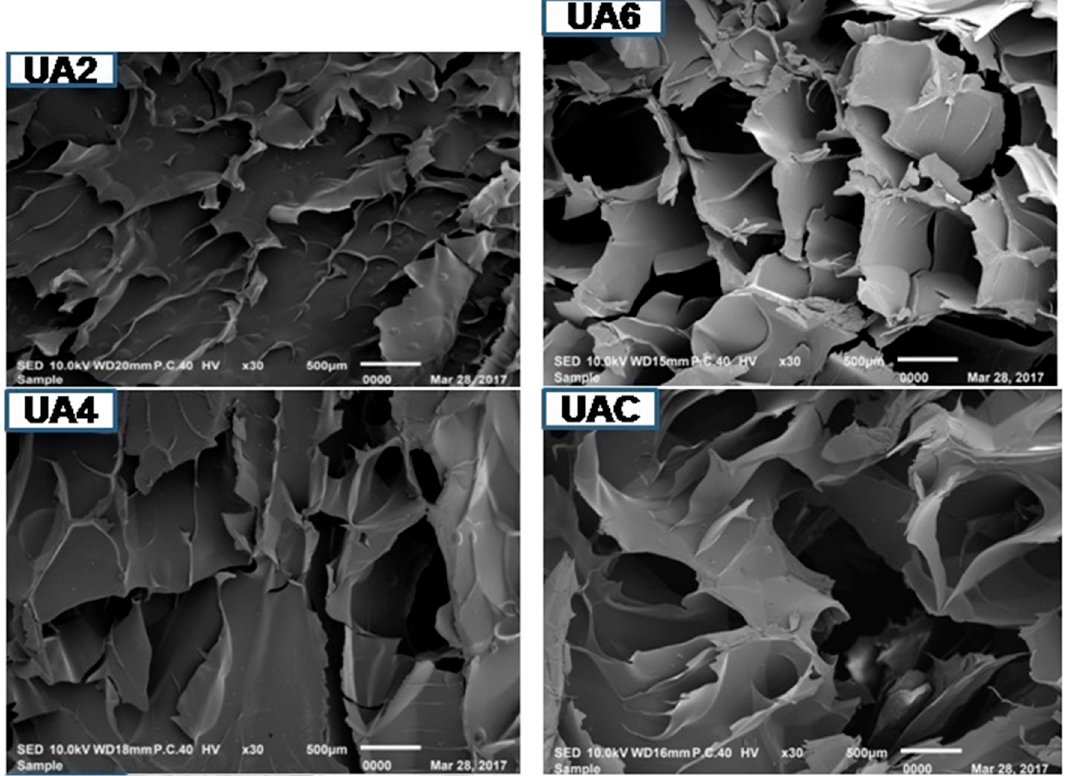
Figure 3. SEM images of gelatin extracted using ultrasound for the time duration of 2, 4 and 6 h (UA2, UA4 and UA6, respectively) with actinidin pretreatment. UAC: control gelatin extracted using ultrasound without enzyme pretreatment.